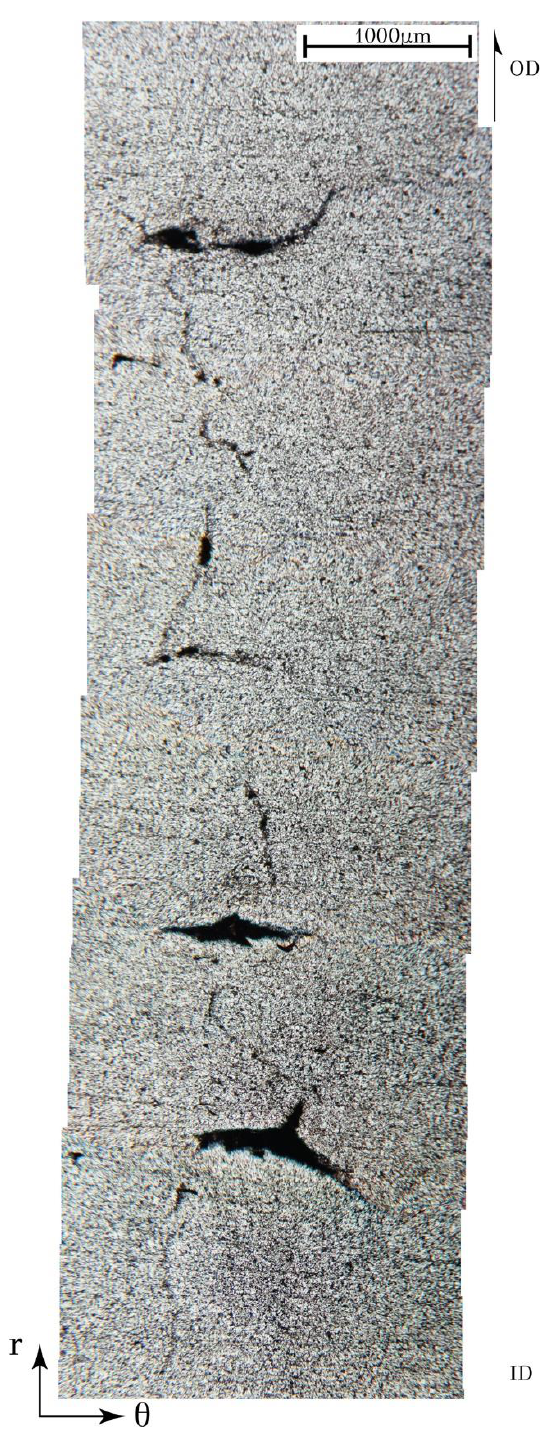
Figure 7. SOHIC cracking at location 604.